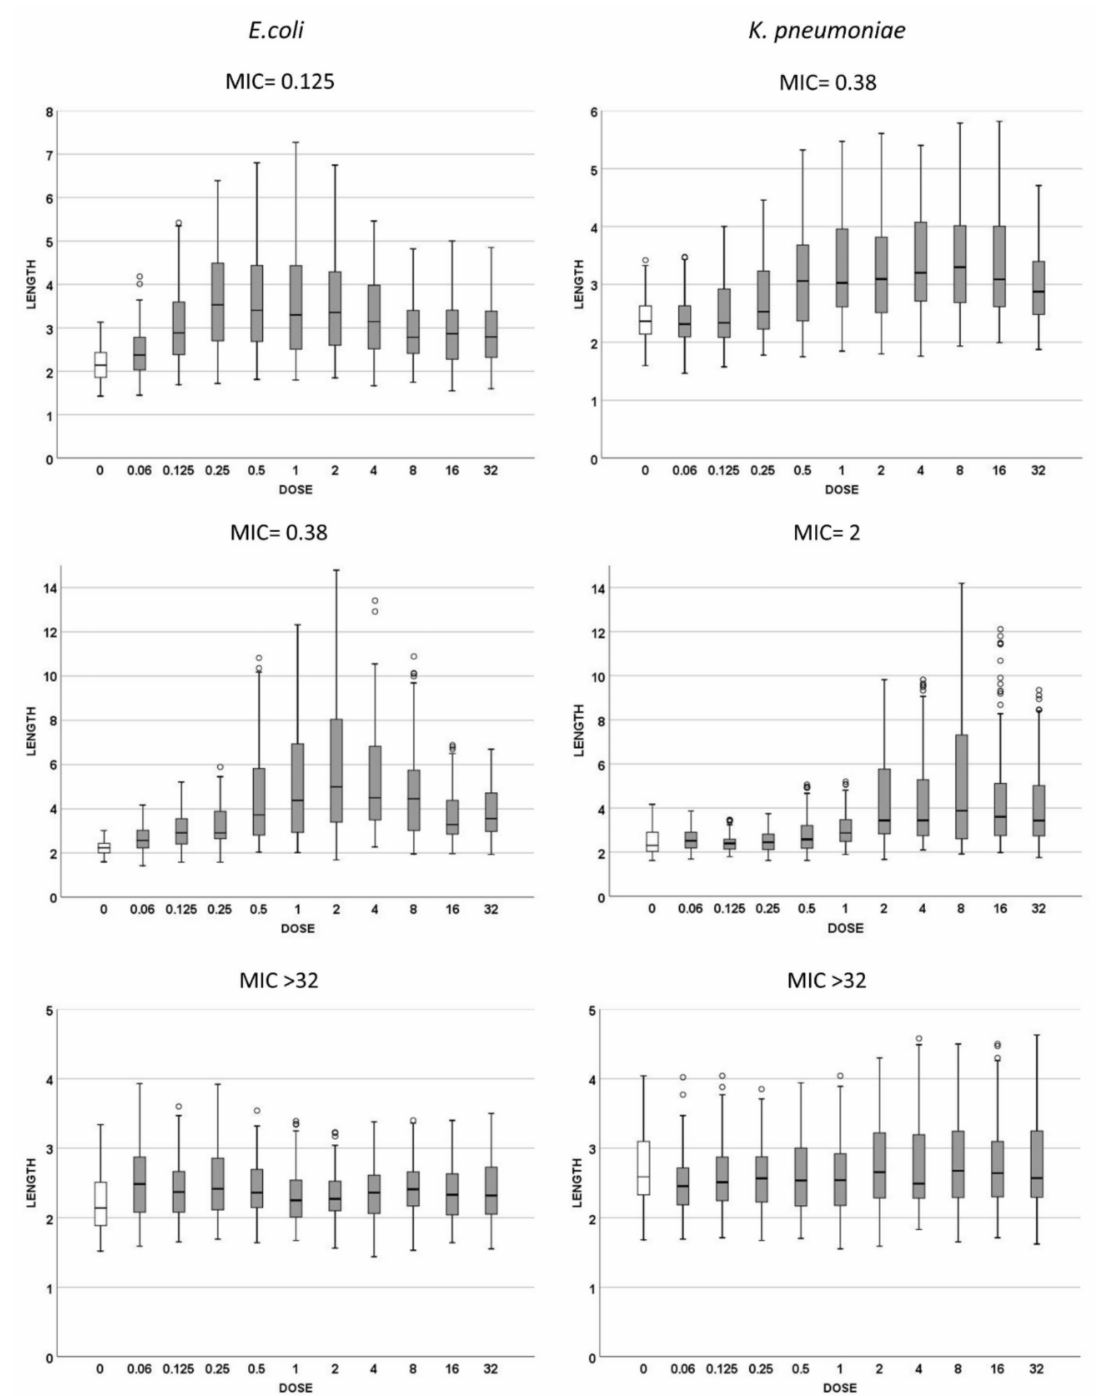
Figure 2. Cell length measures ( µ m) of Escherichia coli (left) and Klebsiella pneumoniae (right) strains with different MICs for cotrimoxazole. The first row corresponds to susceptible strains with MIC 0.125 mg/L for E. coli and 0.38 mg/L for K. pneumoniae ; the second row represents the strains with MIC 0.38 mg/L for E. coli and 2 mg/L for K. pneumoniae ; the third row represents the resistant strains, both with MIC > 32 mg/L. Each strain shows the cell length (vertical axis) measured in cultures incubated with increasing doses of cotrimoxazole, from 0 to 32 mg/L. The data are presented as box and whisker plots. The horizontal line in the box indicates the median, the lower line of the box is the first quartile, the upper line of the box is the third quartile and the whiskers (the end of the vertical lines) are the maximum and minimum values. Abnormal values are presented as dots outside the